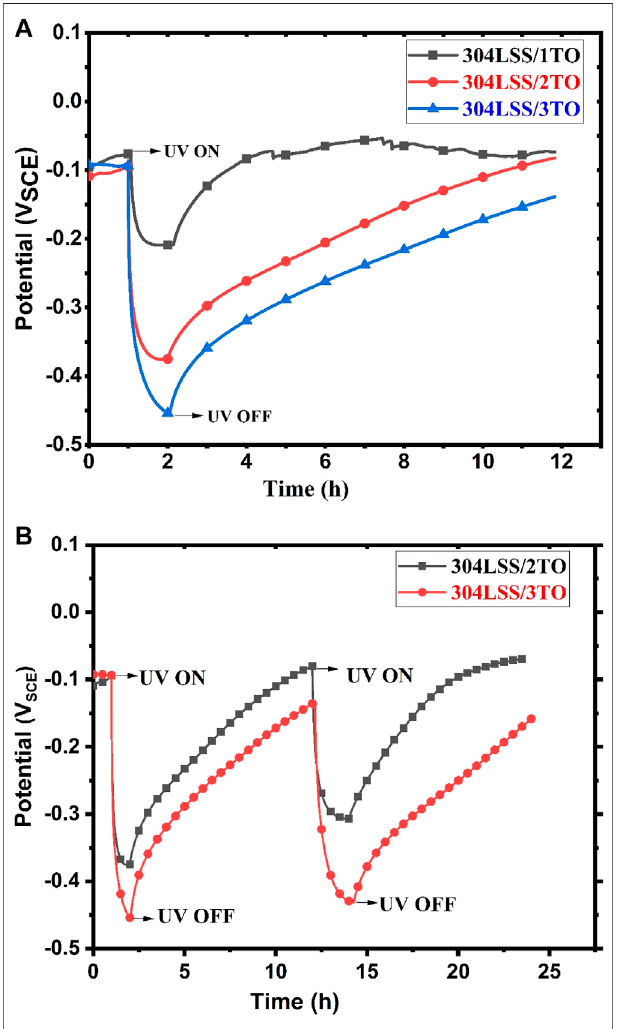
FIGURE 10 | (A) OCP responses of 304LSS/1TO, 304LSS/2TO, and 304LSS/3TO in the designated electrolyte solutions to the absence and presenceofUVillumination. (B) OCPresponsesof304LSS/2TOand304LSS/ 3TOinthedesignatedelectrolytesolutionstotheabsenceandpresence of UV illumination for two cycles.